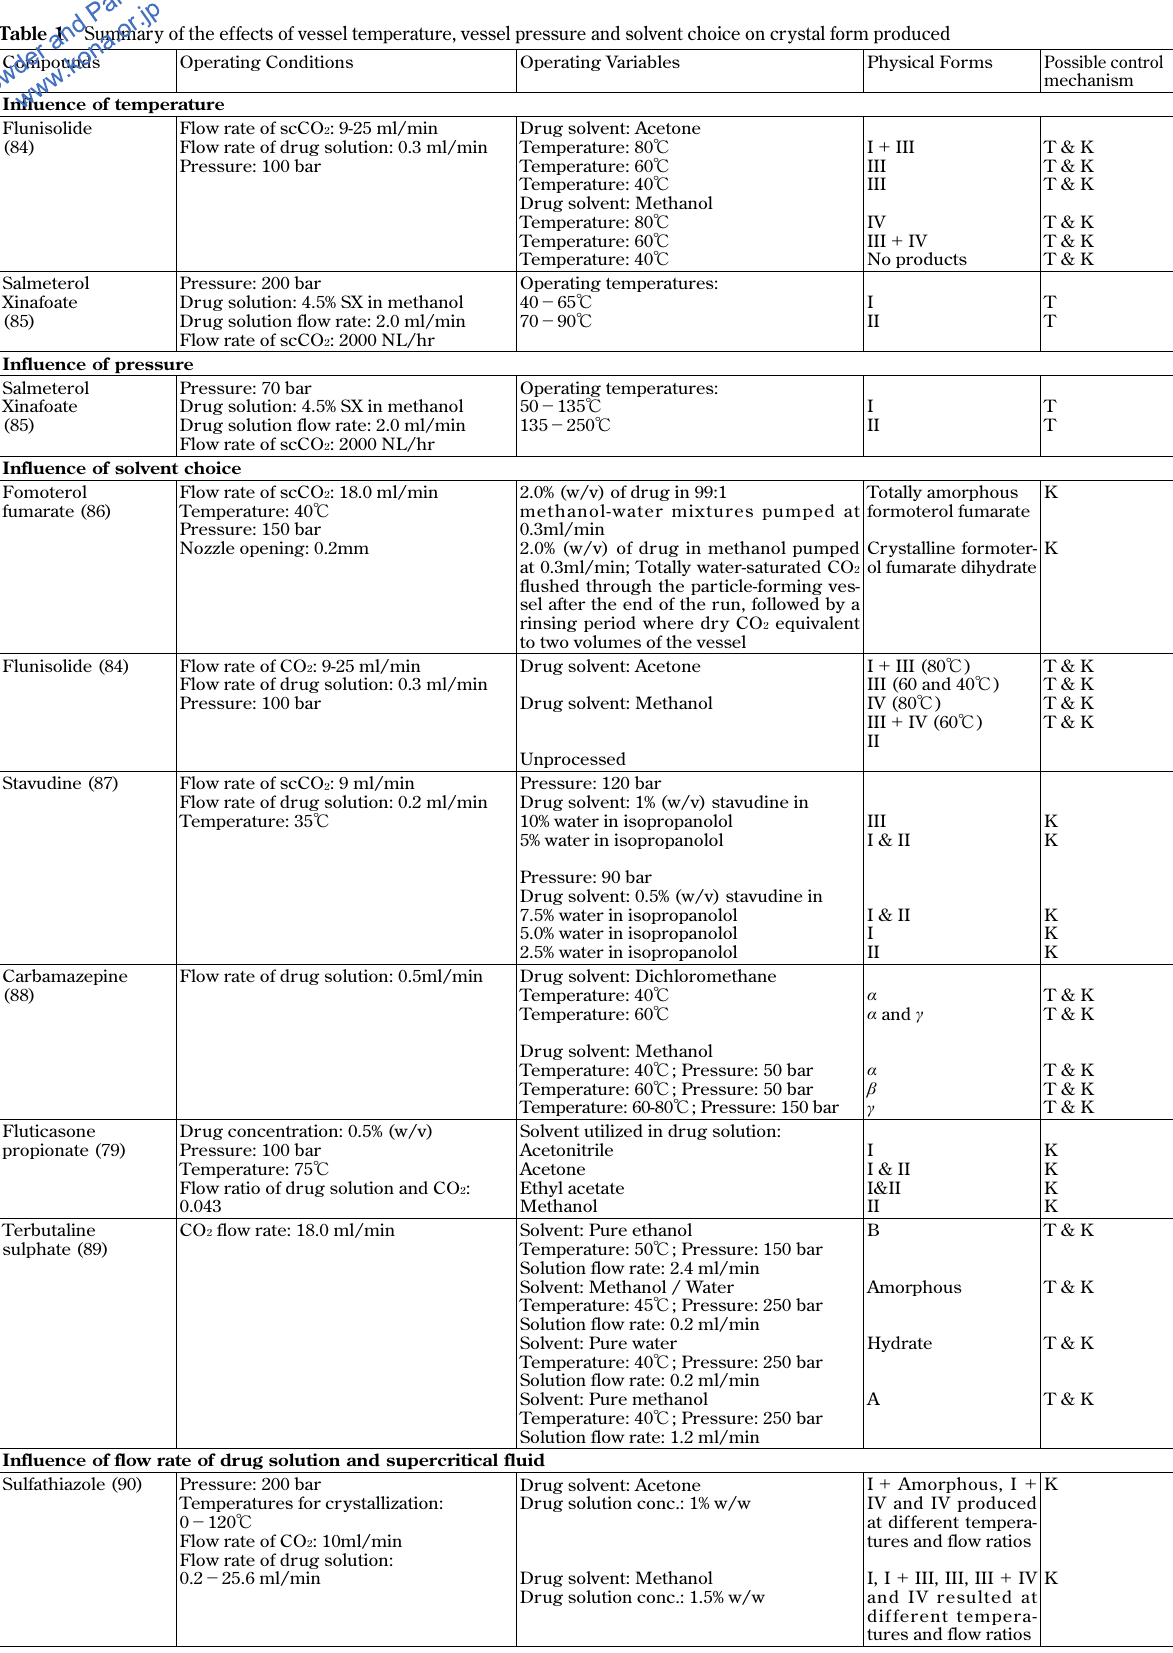
Table 1 Summary of the effects of vessel temperature, vessel pressure and solvent choice on crystal form